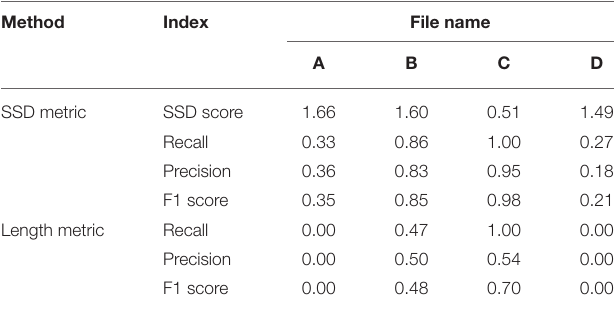
TABLE 3 | PyNeval results of the SSD and length metrics for the geometrical cases are shown in Figures 3A–D .